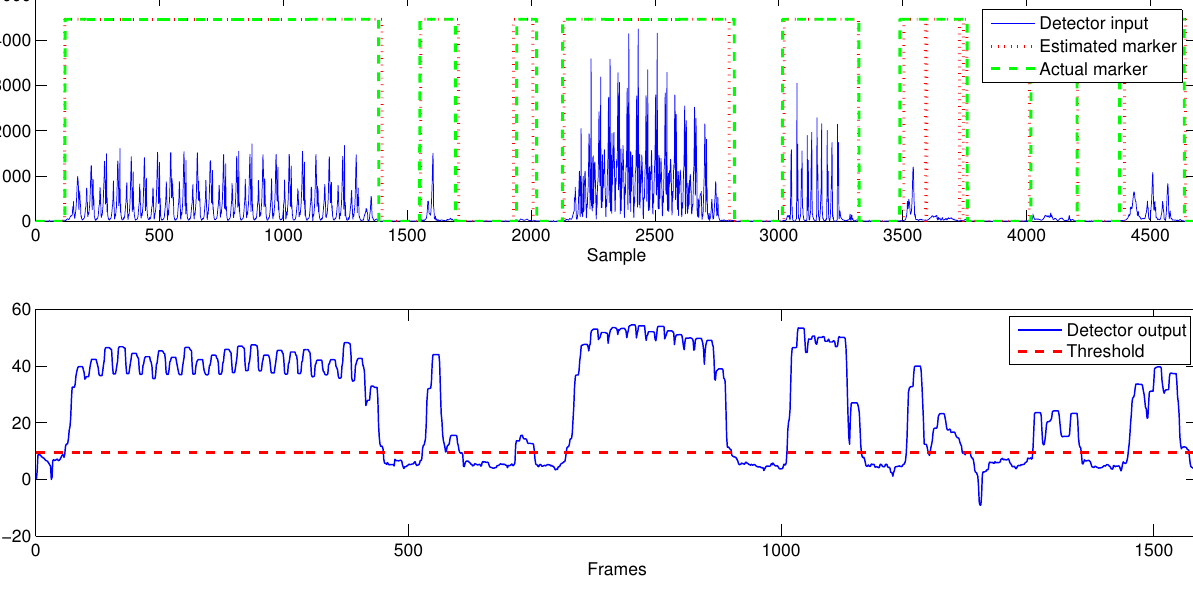
Figure 8. Input and output (vector of characteristics and marker) of the AMVD. Real